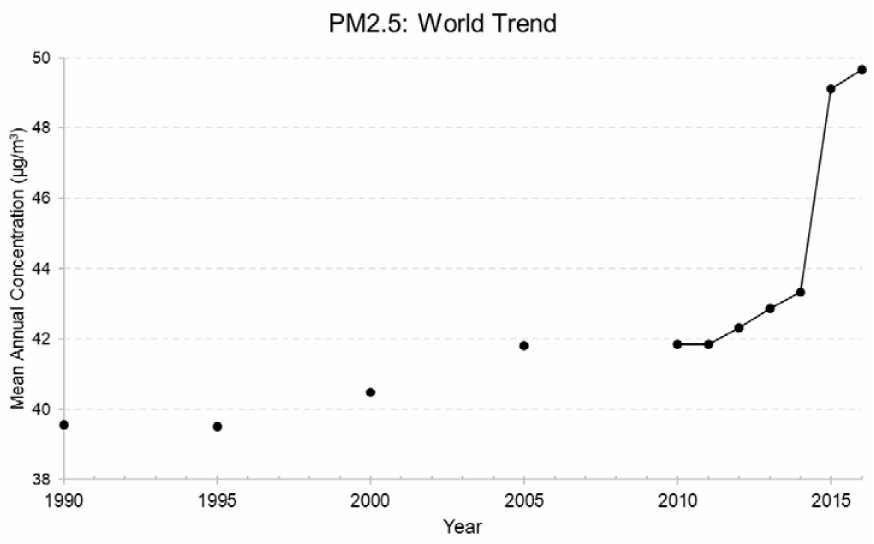
Figure 2. PM 2.5 air pollution, mean annual exposure ( µ g/m 3 ). Data source: World Bank [53].